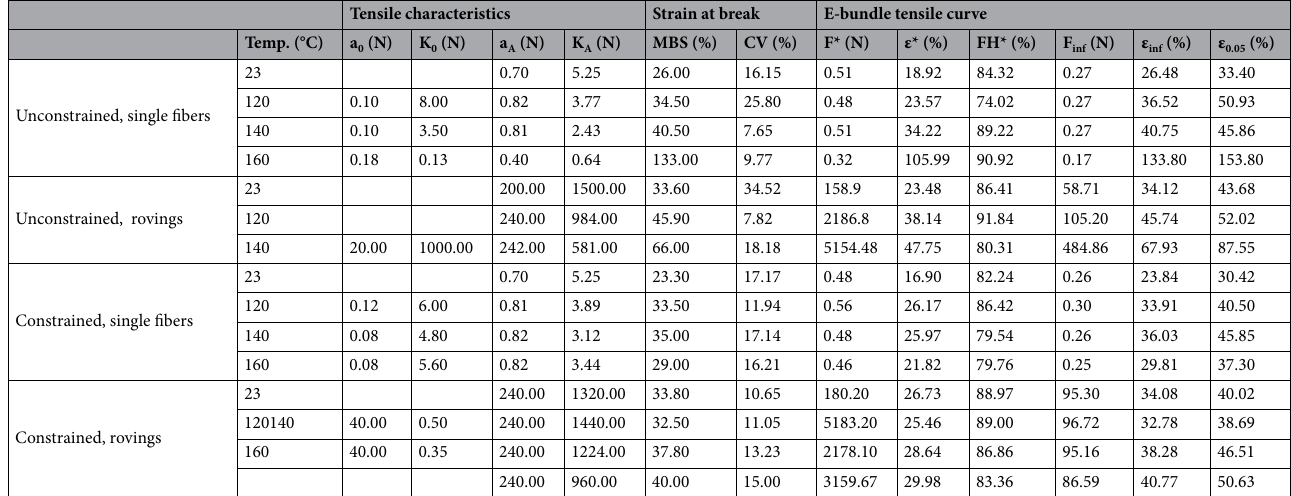
Table 1. Results of testing fibers and rovings and the fitting of FBC